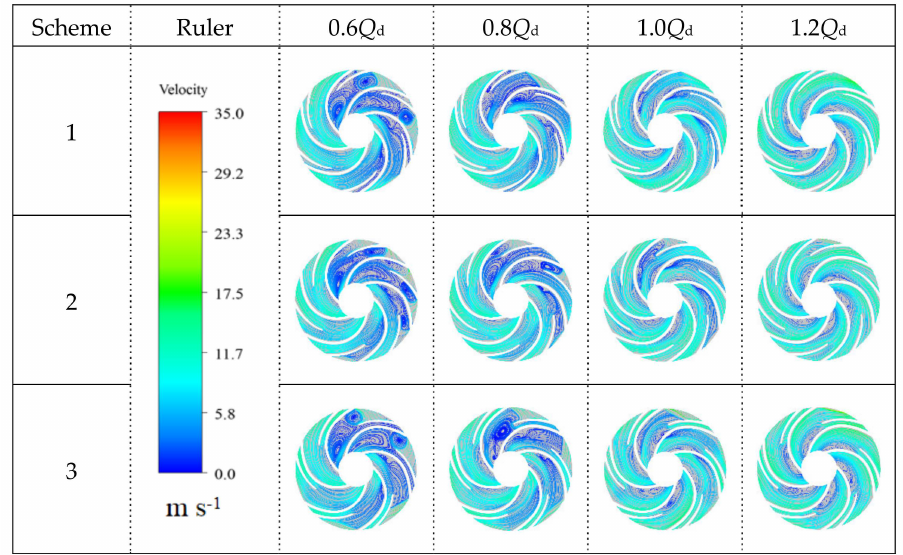
Figure 7. Velocity streamline diagram of a cross-section of the impeller flow field under di ff erent flows in pure water